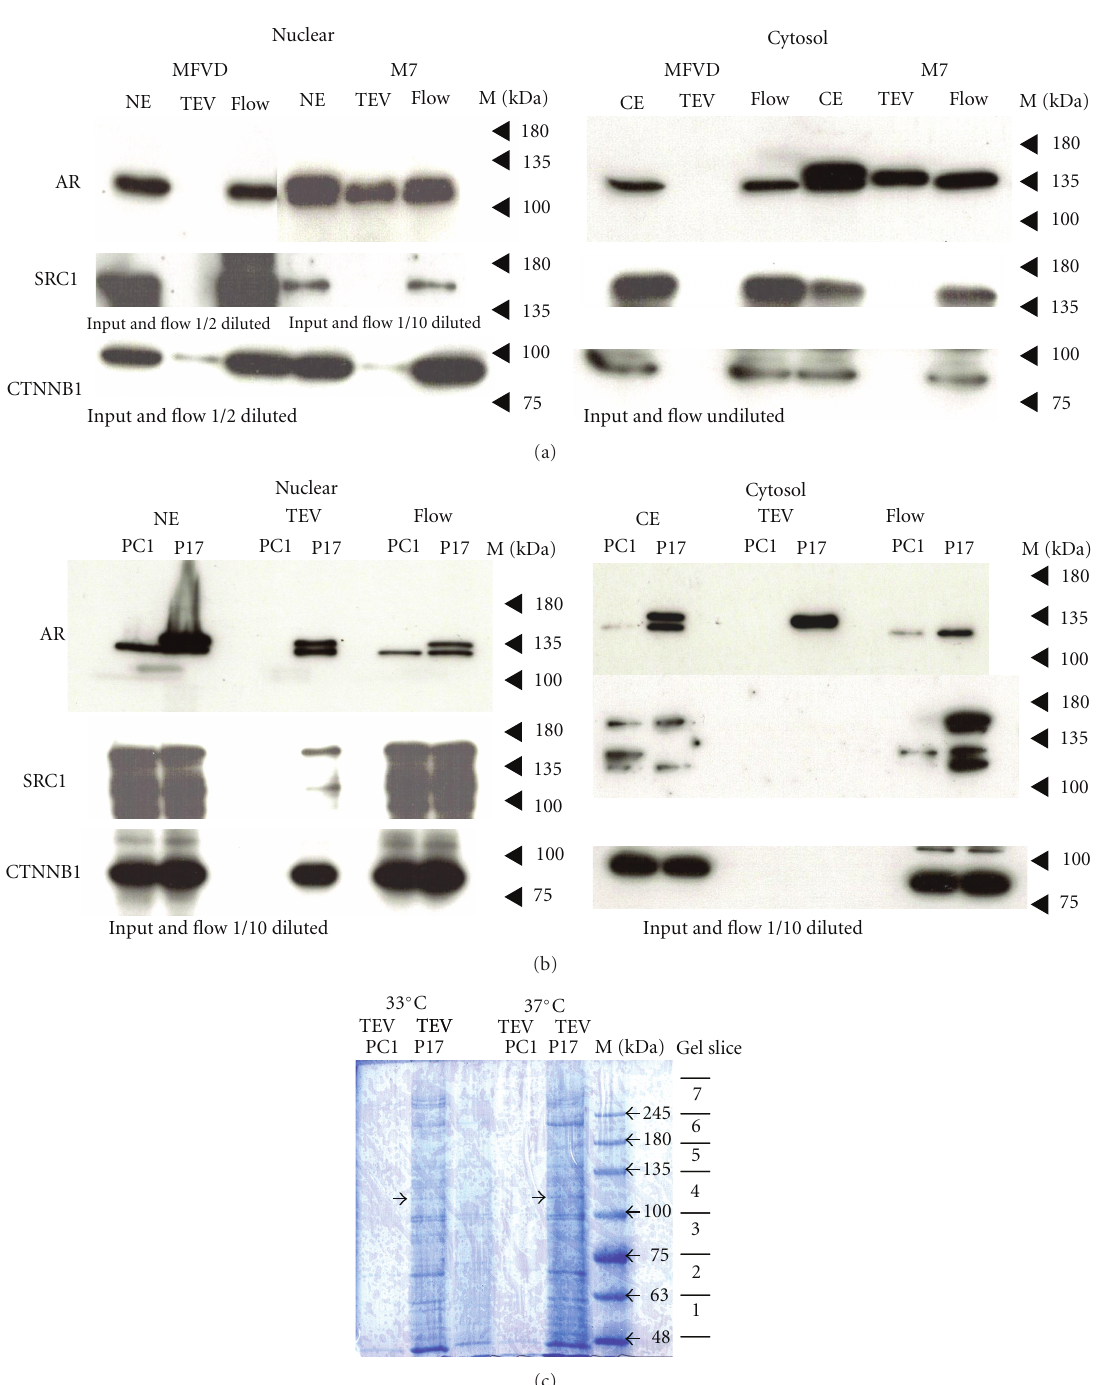
Figure 3: FLAG purifications. (a) Western blot analysis of FLAG-purified M7 nuclear and cytosol extracts using TAP negative MFVD cells as control. Compared are SRC1, beta catenin (CTNNB1), and AR expression in extracts before (NE/CE) and after (FLOW) purification and in the TEV-eluted fractions. AR (WT and N-TAP-mAR comigrate) is recovered in TEV eluate from the M7 but not from the MFVD control purifications. (b) Western blot analysis of FLAG-purified P17 nuclear and cytosol extracts using TAP negative PC1 cells as control. Compared are SRC1, beta catenin, and AR expression in extracts before (NE/CE) and after (FLOW) purification and in the TEV-eluted fractions. AR (WT and N-TAP-mAR are here distinguishable) is recovered in TEV eluate from the P17 but not from the PC1 control purifications. (c) Coomassie stained 5% PAGE loaded with TEV-eluted fractions from the control cell line PC1 and the NTAP-mAR expressing cell line P17 grown at 33 ◦ C and 37 ◦ C after FLAG purification. This gel was prepared for cutting out gel slices (1–7), which were then submitted for mass spectrometry. The arrows indicate the N-TAP-mAR migration. M is the size estimate by a prestained protein ladder in kilo Daltons